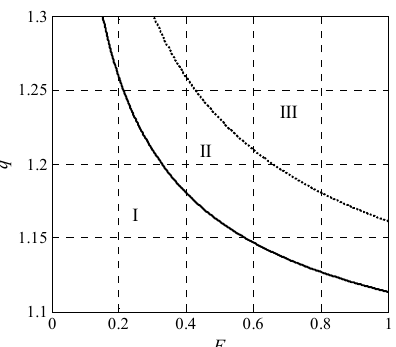
Figure 6. The bifurcation with respect to the slowly varying parameter F and the fractional order q of the fast subsystem.